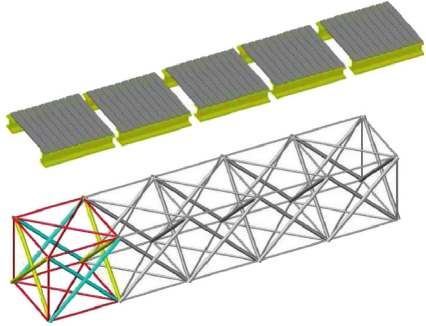
Figure 1: Deployable bridge model.